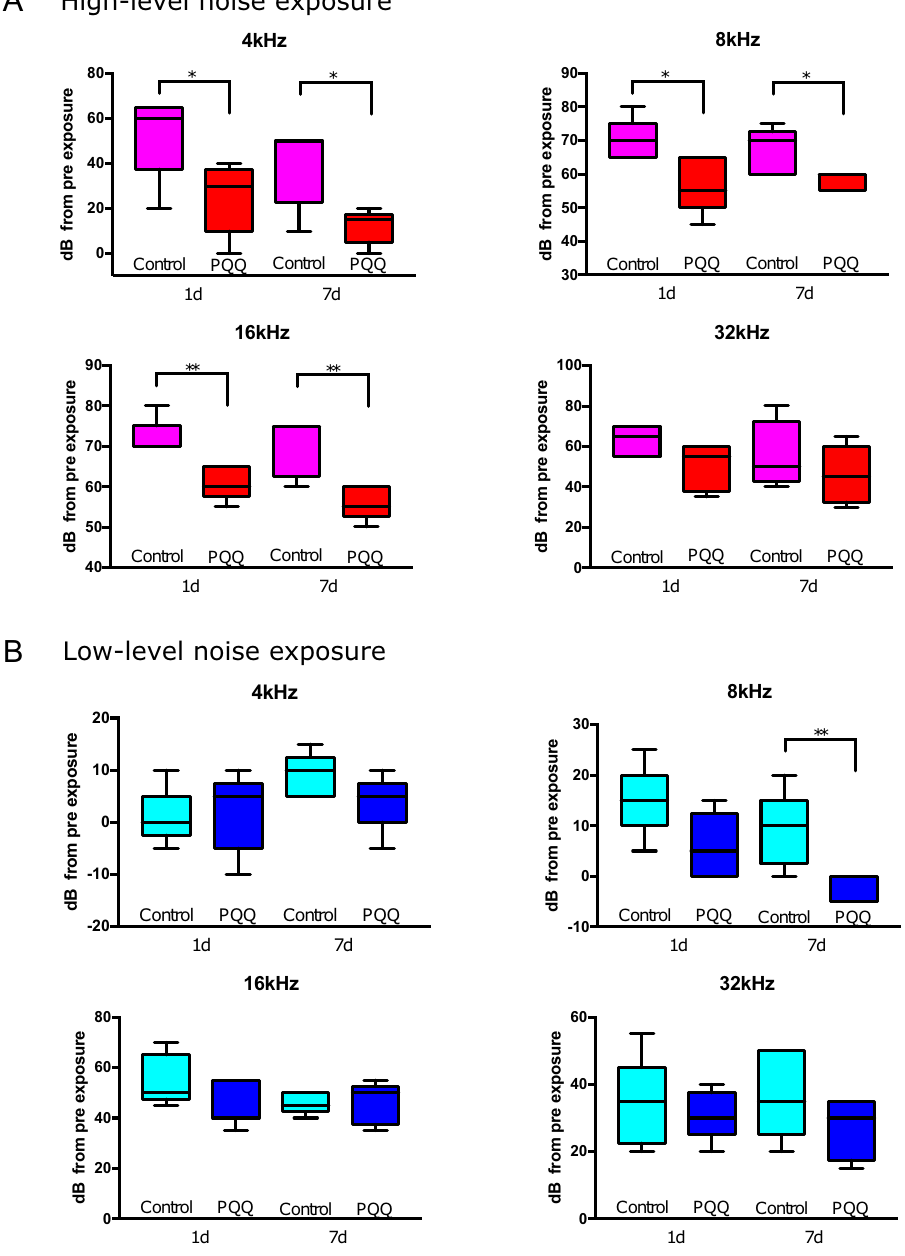
Figure 1. ABR results in the noise-induced hearing loss model ( A ) ABR threshold shifts from pre-exposure thresholds 1 day and 7 days after high-level noise exposure for each frequency (4 kHz, 8 kHz, 16 kHz and 32 kHz). There were significant differences between PQQ-treated animals and the controls at 4 kHz, 8 kHz and 16 kHz. ( B ) ABR thresholds 1 day and 7 days after low-level noise exposure. A significant difference was observed at 8 kHz between low-level noise + PQQ group and low-level noise group. * p < 0.05, ** p < 0.01. ( n = 5 per